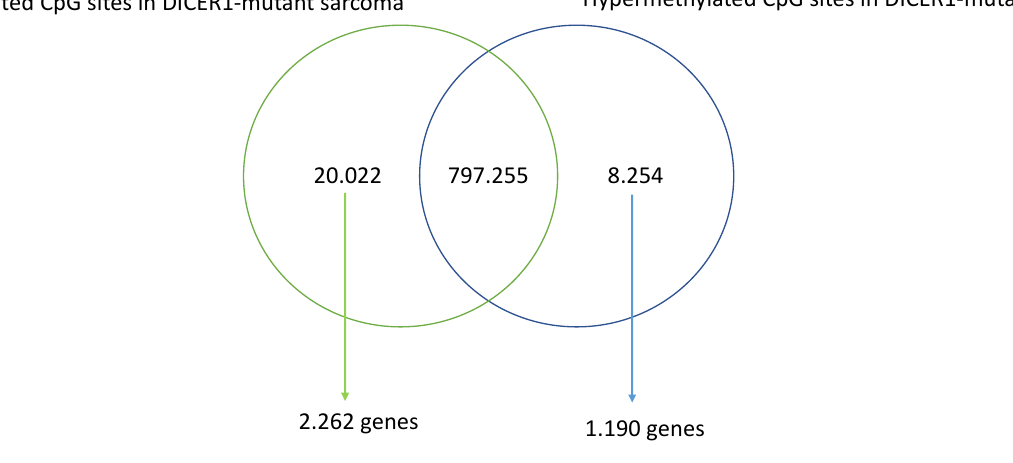
Figure 5. VENN diagram showing the number of CpG sites differentially methylated in primary intracranial sarcoma, DICER1 -mutant, compared with mesenchymal glioblastoma (gliosarcoma). Raw data (IDAT files) were analyzed with RnBeads R-based scripts.